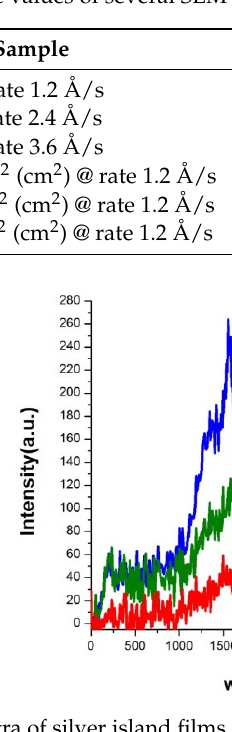
Figure 7. Raman spectra of silver island films deposited with evaporation rates of 1.2, 2.4, and 3.6 Å/s. The exposure time was 20 s.